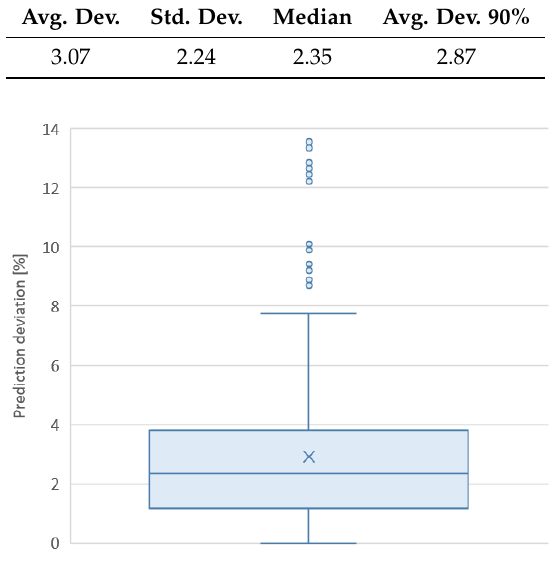
Figure 6. Prediction deviation of the Young’s modulus.